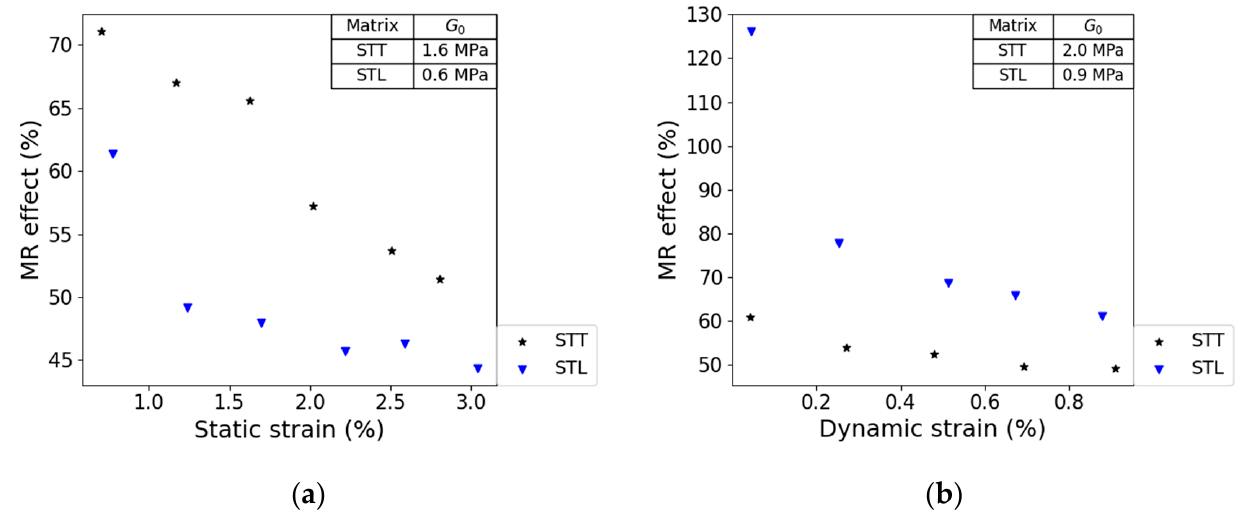
Figure 9. The influence of matrix material during static ( a ) and dynamic ( b ) strain on the MR effect. Composites STL30CC and STT30CC were used for this analysis. A constant strain amplitude of 1%was used for the static tests. A constant frequency of 10 Hz and field strength of 0.54 T were used for both test conditions.